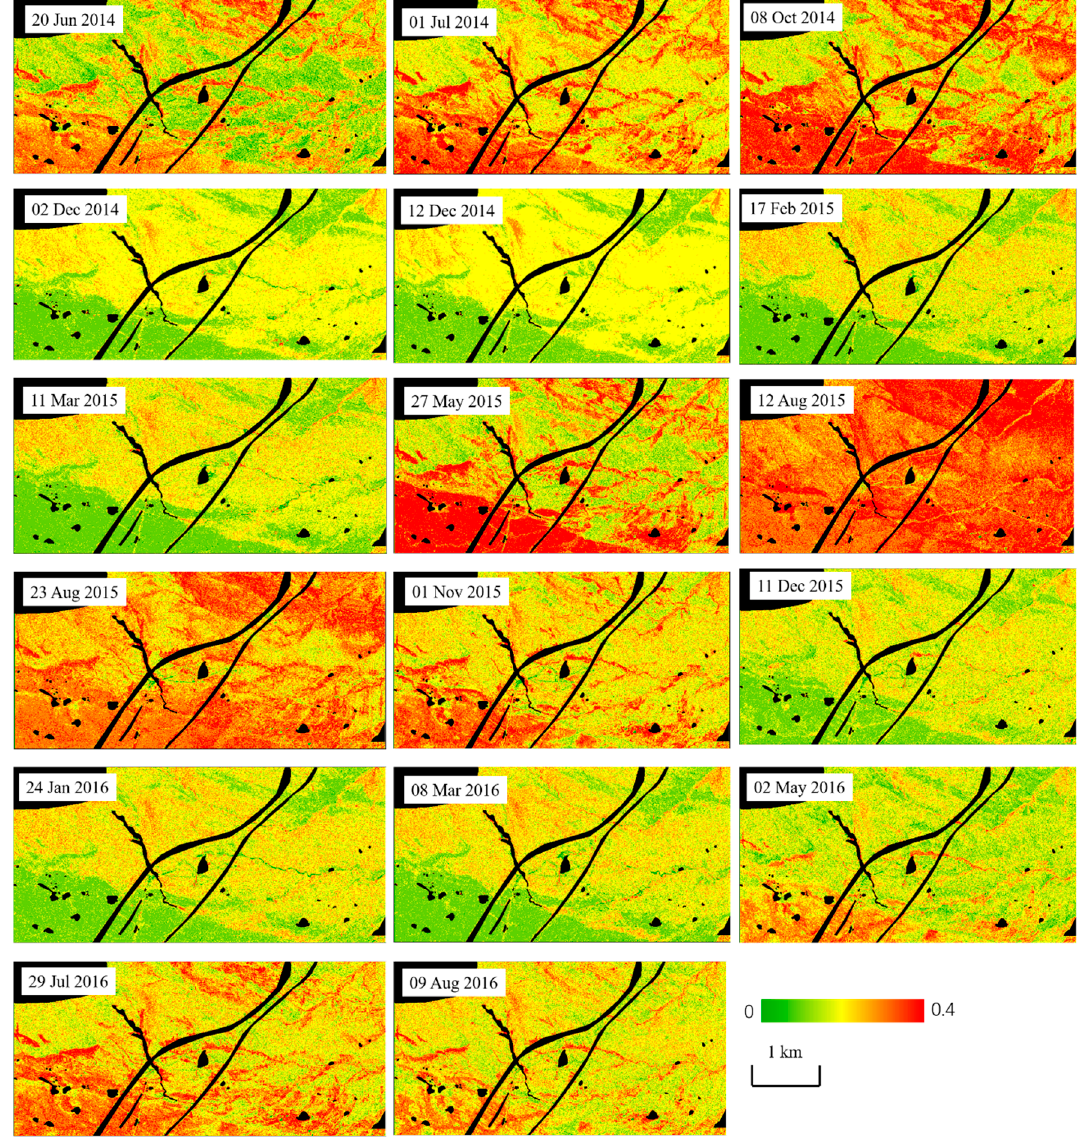
Figure 11. Series of soil moisture maps retrieved from TerraSAR-X using the time-series approach during the whole observation period. Black areas are masks of open water, railway, and highway.